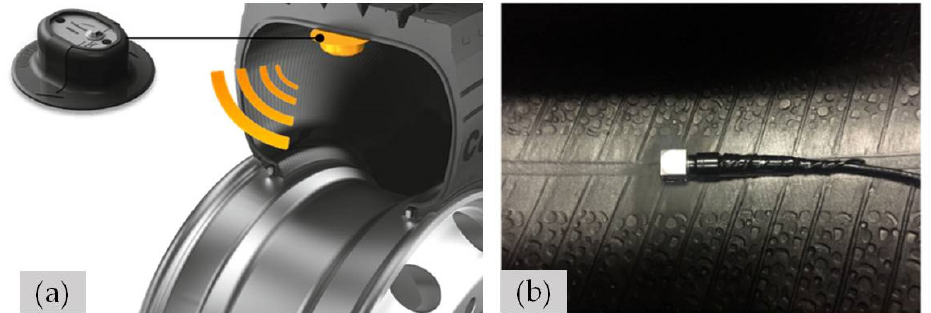
Figure 9. Typical examples of ( a ) adhesive tire sensors and ( b ) adhesive tread sensors (tri-axial accelerometer).